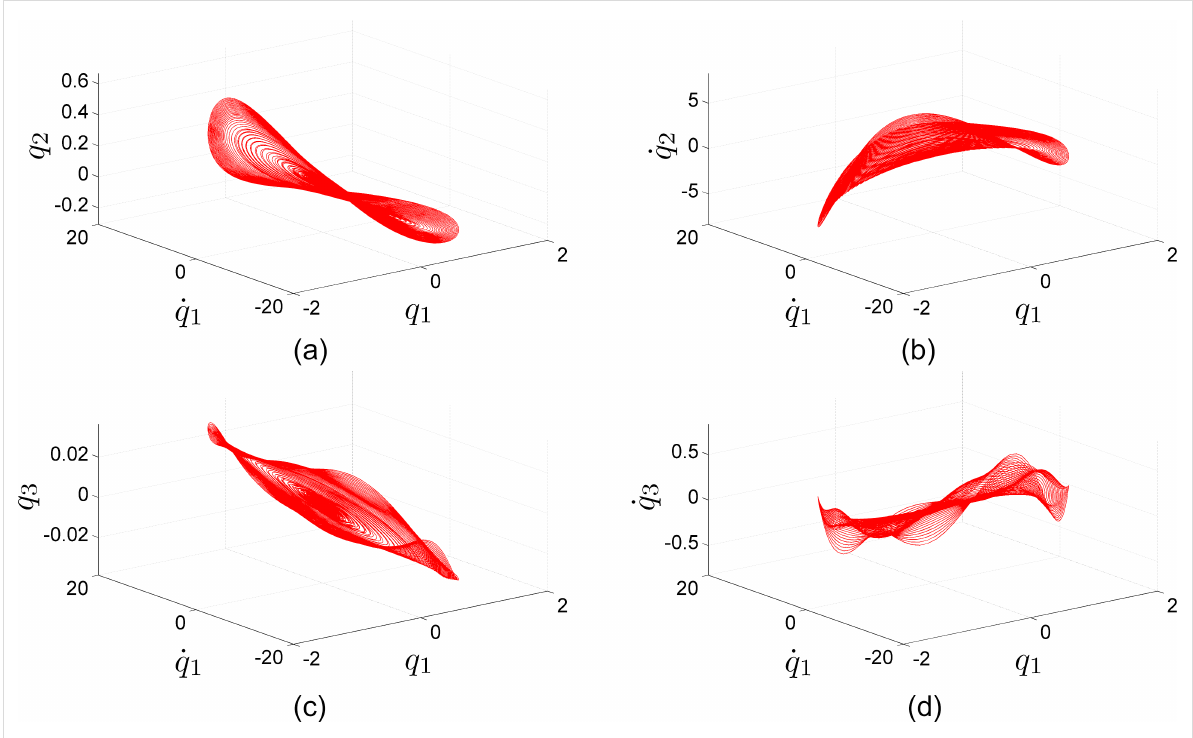
Figure 3: Steady-state periodic orbits (nonlinear normal modes) from simulations in Figure 1 projected onto phase space comprised of state vari- ables. (a) Second basis function displacement q 2 and (b) velocity , as well as (c) third basis function displacement q 3 and (d) velocity are plotted against first basis function displacement q 1 and velocity